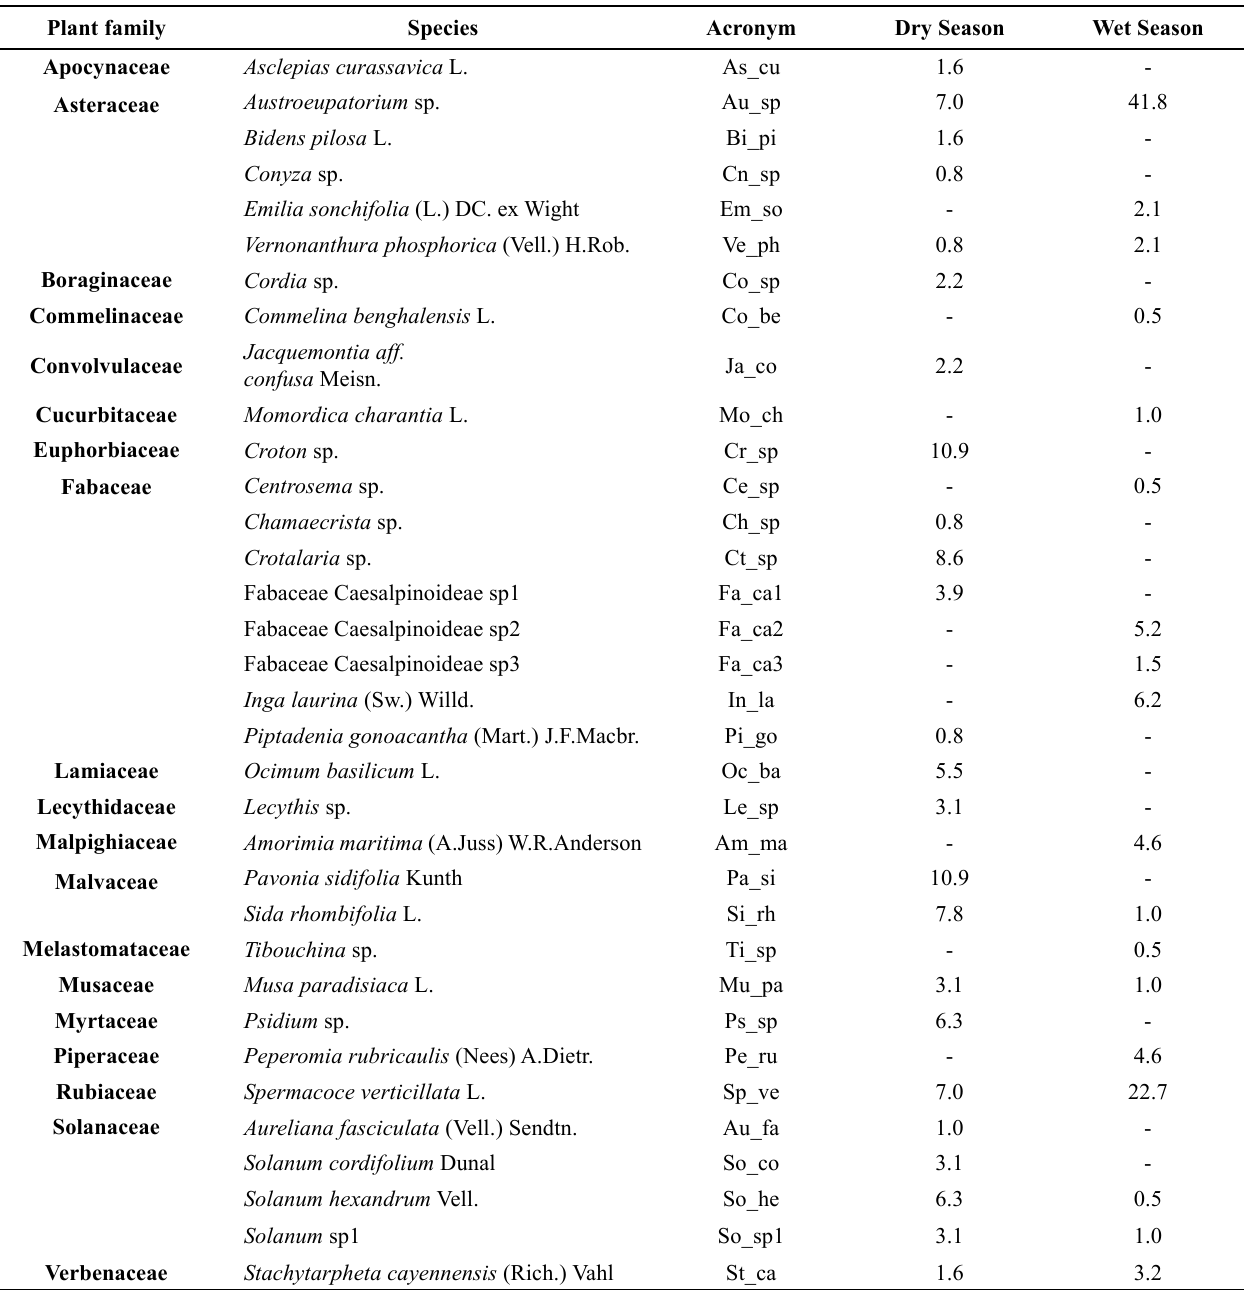
Table 2 . Species composition (and acronyms) of the plants visited by bees and relative abundance of their visitors in the dry and wet seasons on the Itaoca Inselberg in the Atlantic Forest in southeastern